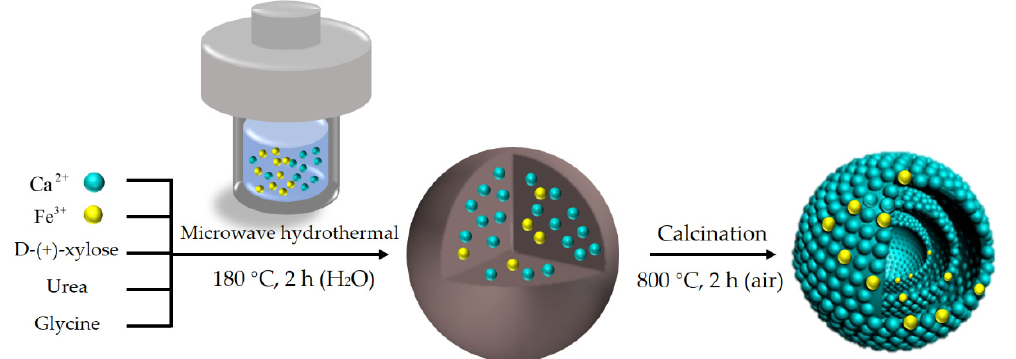
Figure 1. Preparation process of the catalyst.